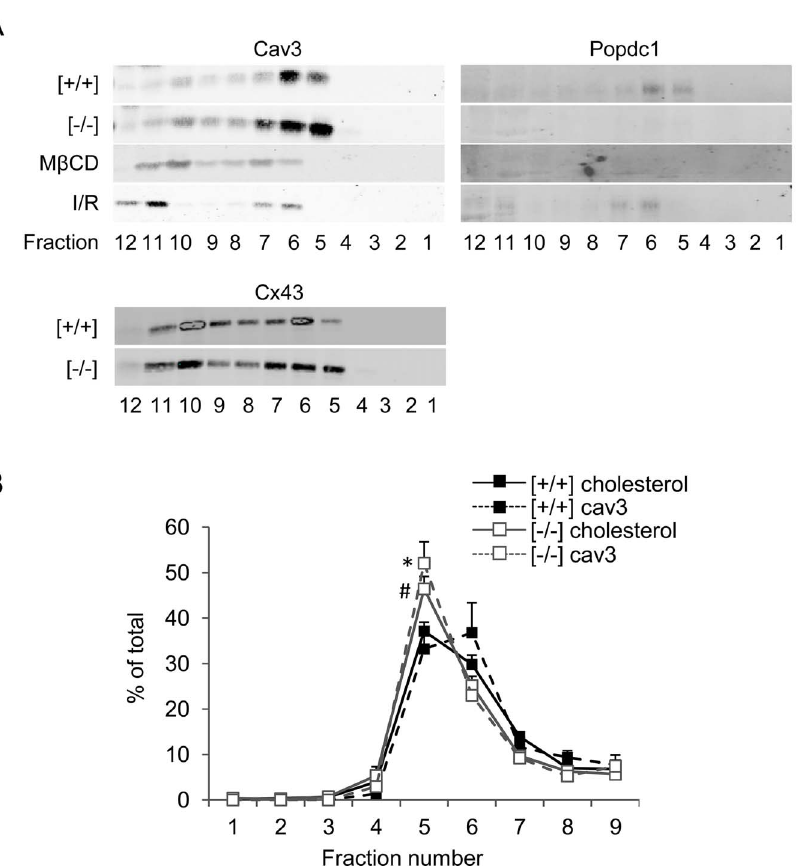
Figure 3. Popdc1 density sedimentation in discontinuous sucrose gradients. (a) Western blot analysis of gradient fractions. Fraction 1 and fraction 12 represent the lowest and highest density, respectively. [ + / + ], WT; [ 2 / 2 ], Popdc1-null; M b CD, methyl- b -cyclodextrin; I/R, ischemia/ reperfusion; Cx43, connexin43. The molecular weights of the reactive bands were , 68 kDa, , 22 kDa, and , 43 kDa, for Popdc1, Cav3, and Cx43, respectively. (b) The relative distribution of cholesterol and Cav3 throughout gradient fractions 1–9. *P , 0.05, Cav3 in fraction 5, Popdc1-null vs. WT; # P , 0.05, cholesterol in fraction 5, Popdc1-null vs. WT.